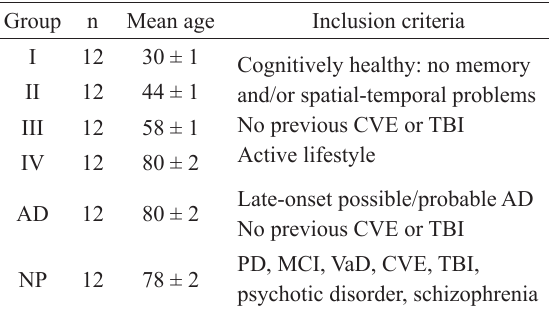
Sample classification and inclusion